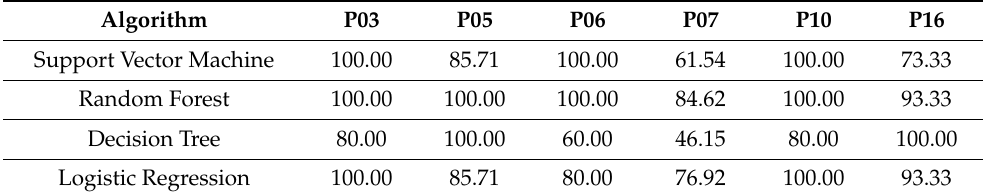
Table 8. Accuracy (%) of every ML model obtained with only the feature-selected variables.